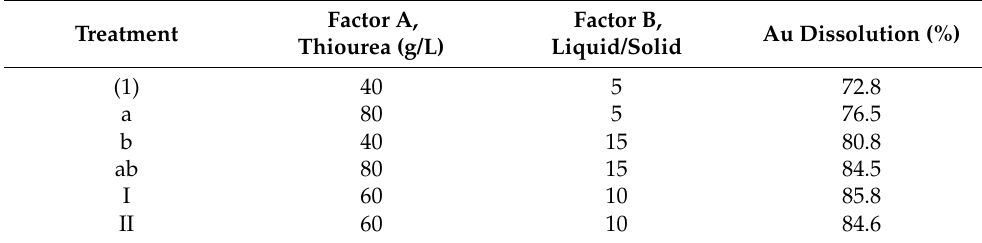
Table 8. Results of 2 2 full factorial design with two replicated central